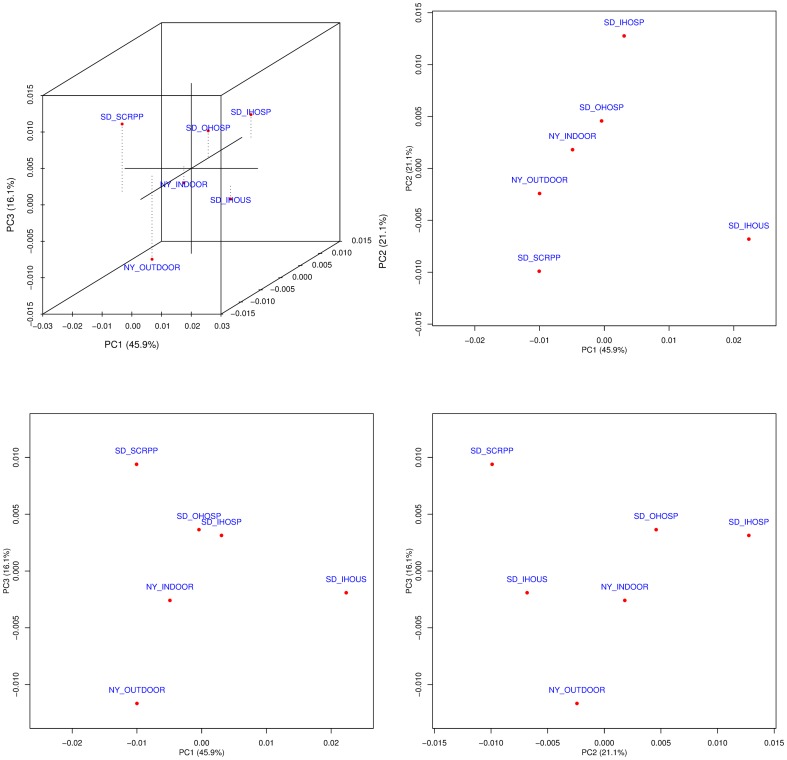
Ordination of the six metagenomic samples by principal component analysis based on KO abundance profiles.The first three principal components (PC1, PC2, and PC3) account for 83.1% of the total variation. The dashed lines in the 3D plot shows the height (PC3) of the sample points when projected on to the PC1-PC2 plane.